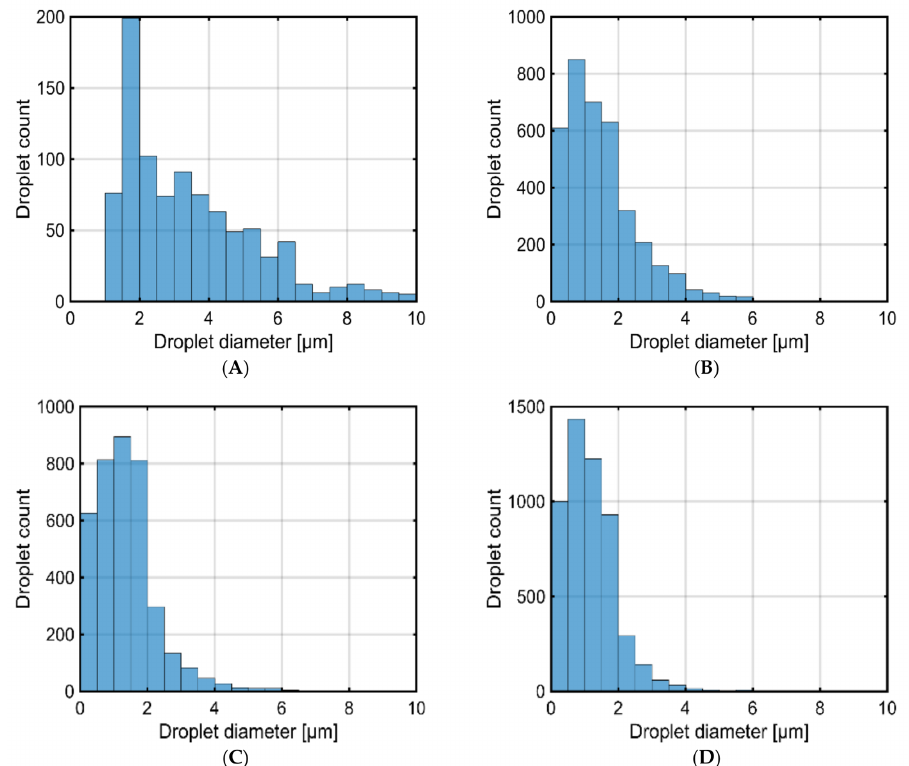
Figure 4. Represent the histogram for the emulsions of 10% water content at: ( A ) fuel in tank and ( B ), ( C , D ) emulsions collected from the spray at 500, 1000 and 1500 bar